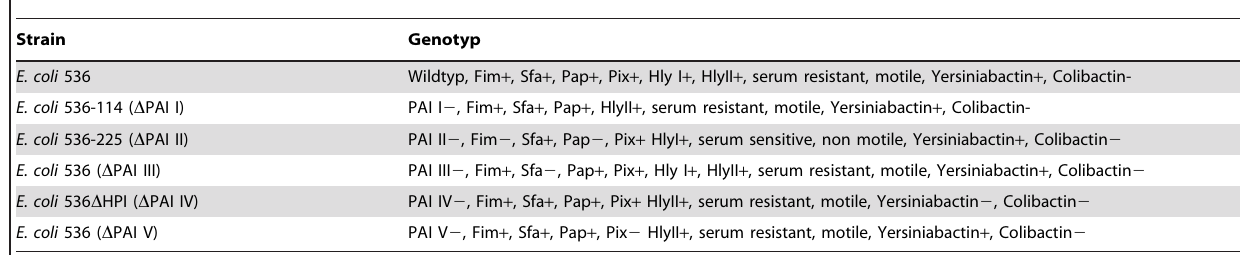
Table 1. Genotype of UPEC strain 536 and deletion mutants.